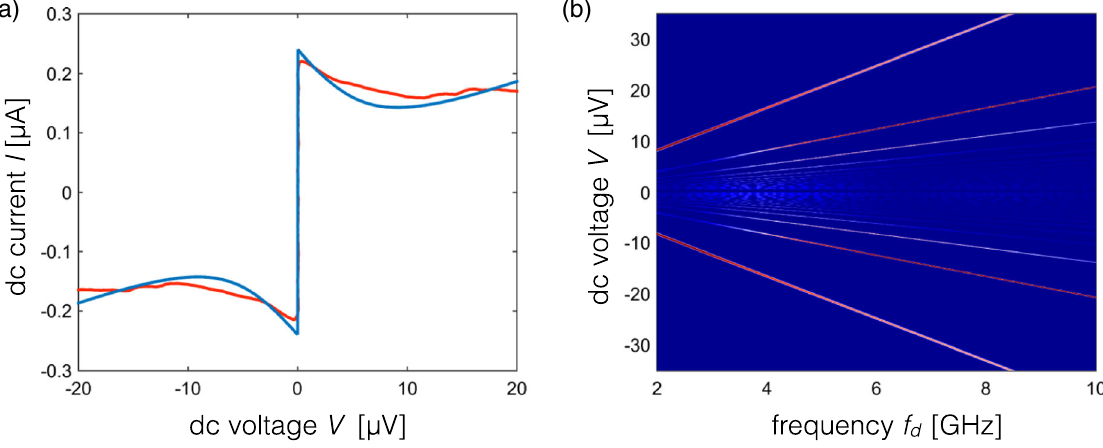
¼ − 0 . 55 V. The g ¼ R ¼ 24 Ω , R ¼ 130 Ω , I ¼ 100 nA, and I ¼ 240 nA. (b) Simulated Fourier transform of the 4 π I S n c and voltage V , for the same simulation parameters as in (a). A good d = 2 for low voltages (below 12 μ V) is J